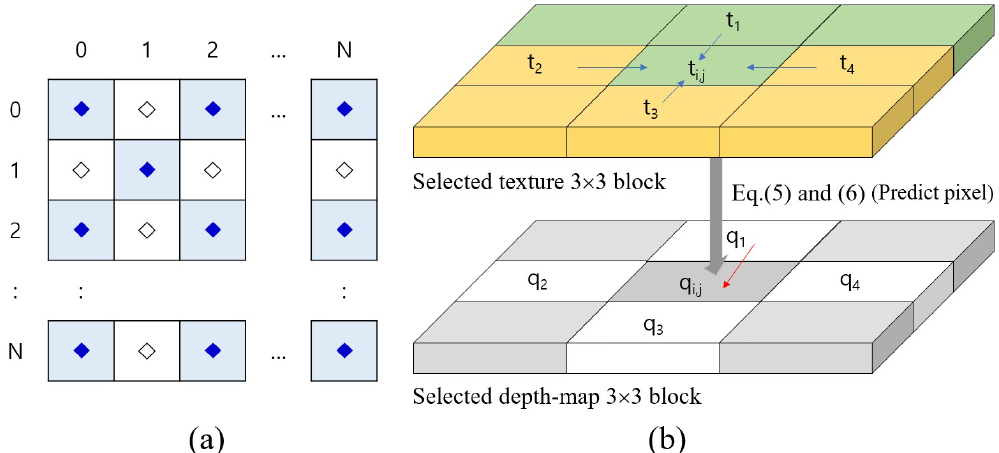
Figure 3. Diagram for configuration of the depth map, and inter-component prediction based on the corresponding texture